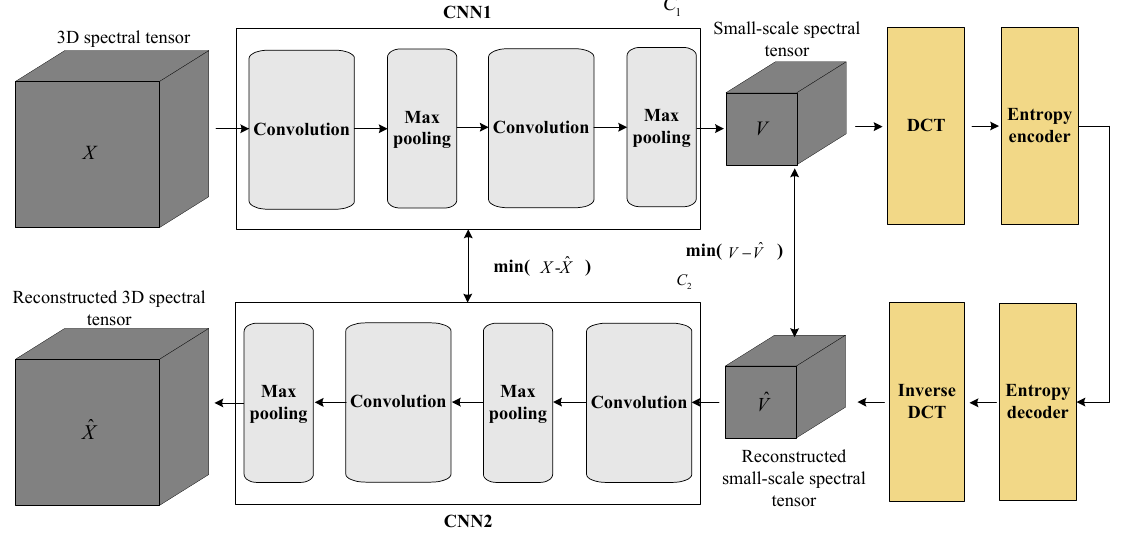
Figure 3. Small-scale multispectral tensor concept with convolution neural networks.